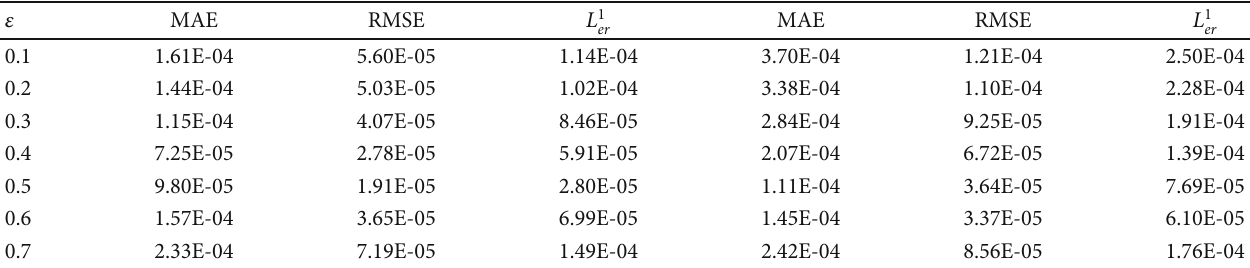
Table 2: Results for di ff erent values of ε in Example 1 with N with Dirichlet conditions.